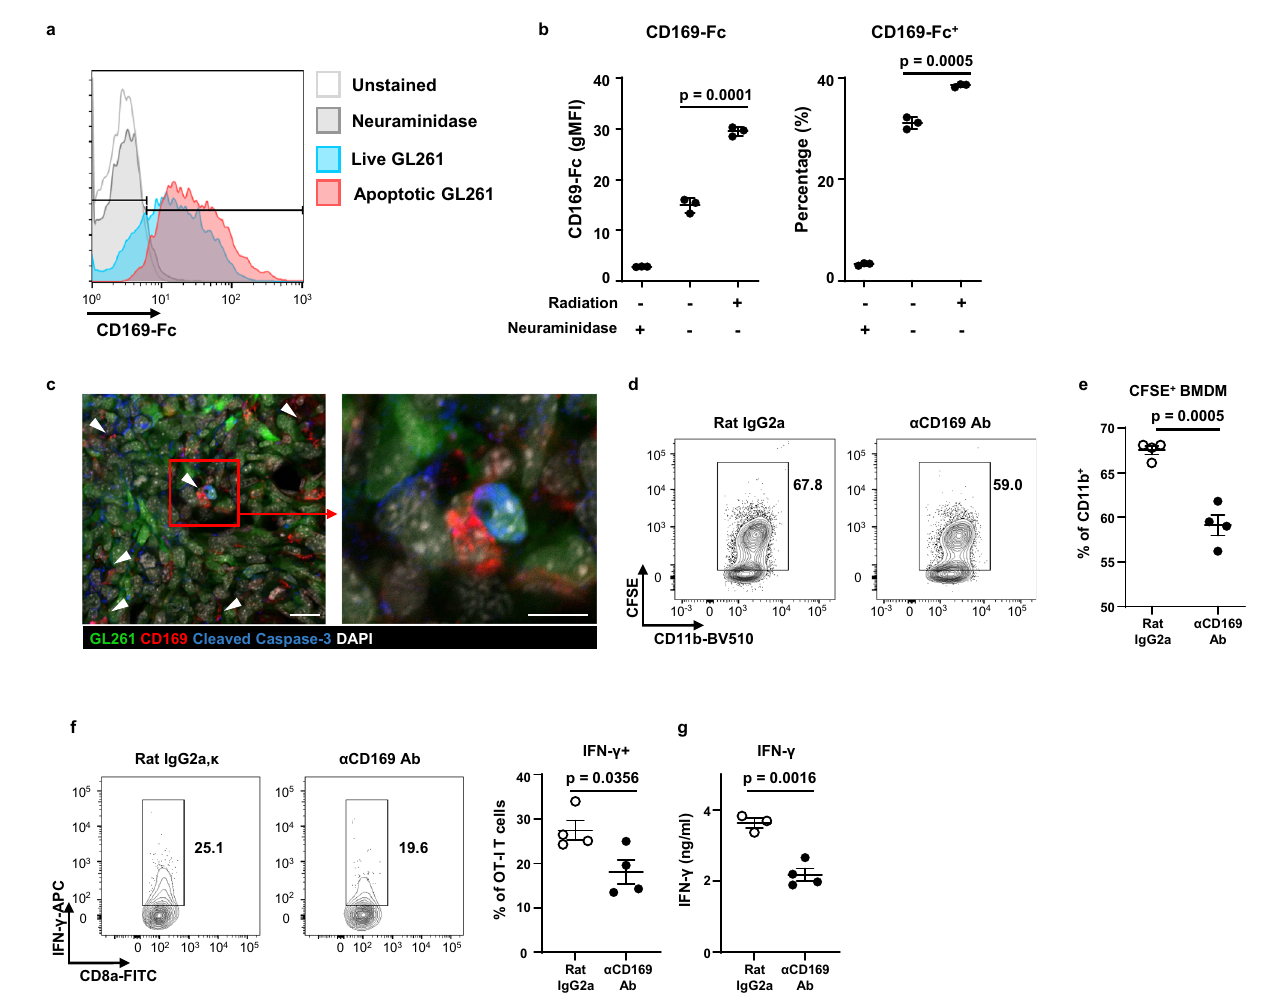
Fig. 6 | CD169 enhances phagocytosis of apoptotic tumor cells. a , b Live or apoptoticGL261wereincubatedwithCD169-FcandAF647-conjugatedanti-mouse IgG to detect CD169 ligand on the cell surface. Neuraminidase was applied before CD169-Fctreatmentasanegativecontrol. a Cellswereanalyzedby fl owcytometry. b Geometric mean fl uorescence intensity (gMFI) and percentage of CD169-ligand + cells were measured. Data represent two independent experiments. c Co- localizationof CD169 + macrophagesandapoptotictumor cellsexpressingcleaved caspase-3inglioma( n =3biologicallyindependentmice)wasdetectedbyconfocal microscopy.Theimageontherightisamagni fi edversionoftheimageontheleft. Data represent two independent experiments. Scale bars indicate 20 μ m for the left image and 10 μ m for the right image. White arrows indicate co-localized regions. These images represent twoindependent experiments. d , e BMDMs were